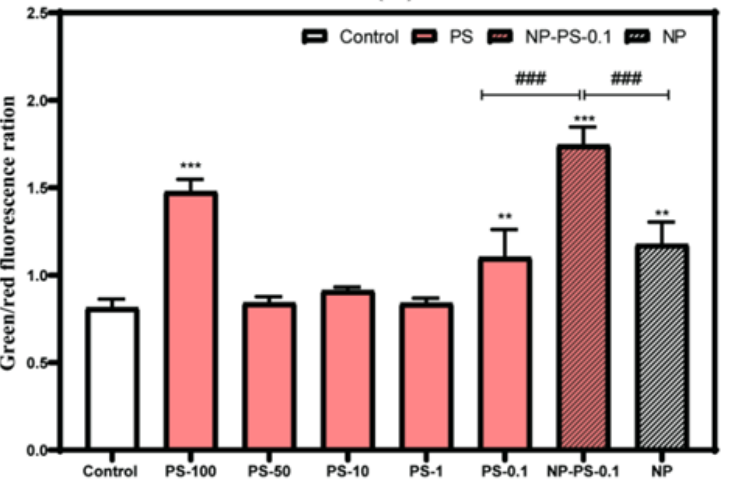
Figure 6. The mitochondrial membrane potential depolarization of Caco-2 cells treated with 40 µ mol/L NP, 500 mg/L PS-MPs (with different particle sizes), and 0.1 µ m PS-MPs that absorbed NP at 48 h; the fluorescence values were calculated by Image J software (National Institute of Mental Health, USA) and the ratio of red to green fluorescence reflected the degree of mitochondrial membrane depolarization (2). * indicates the significant difference between the treatment group and the control group (** p < 0.001, *** p < 0.0005). # indicates the significant difference between the marked groups ( ### p < 0.0005).